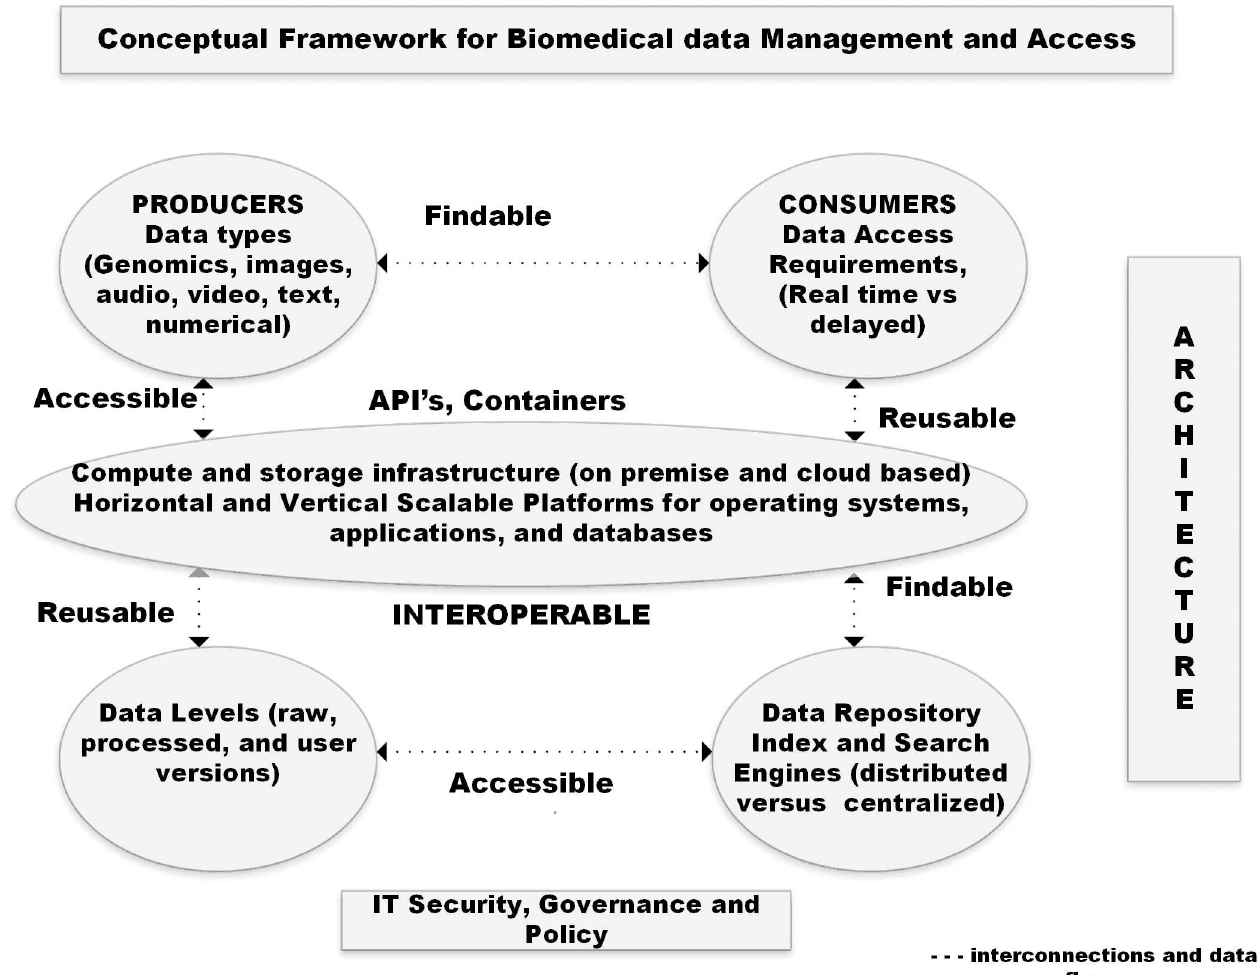
Fig 1. Conceptual cloud-based platform with different data types that flow between producers and consumers requiring variable data level